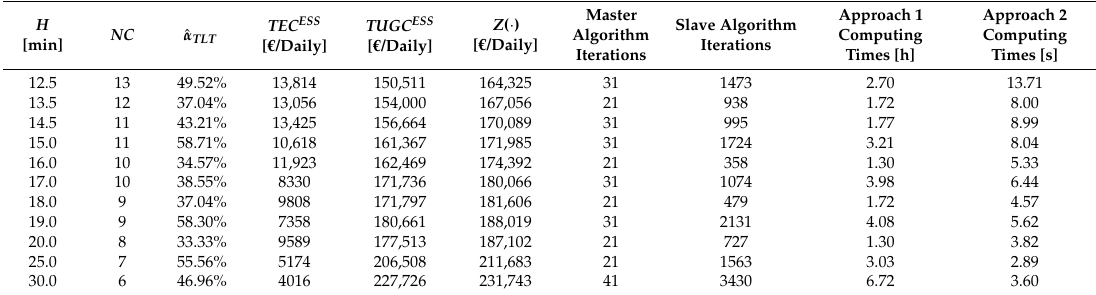
Table 8. Solution algorithm performance in the case of 90th percentile.